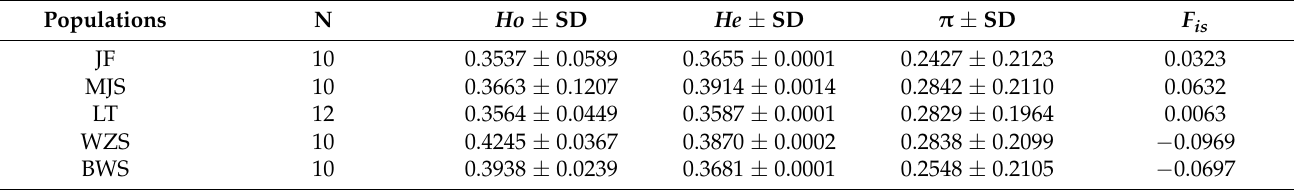
Table 1. Genetic diversity statistics among different the 5 P. bungeana